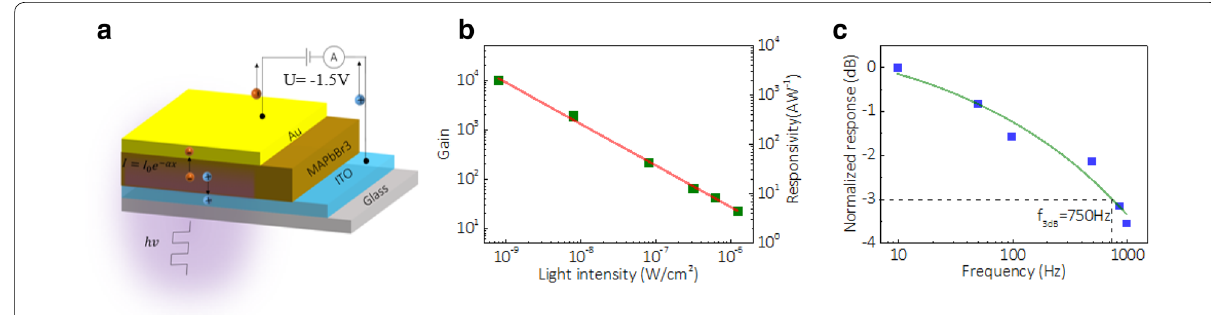
Fig. 4 Characterization of MAPbBr 3 SC‑TF photodetector. a Structure of the device. The film is sandwiched in the ITO substrate and top Au electrode, forming a metal–semiconductor‑metal structure. b Gain and responsivity of the device at different incident power density. The largest gain is ~ 10 4 which benefits from the high crystallinity and thin thickness of the active layer. c 3 dB bandwidth of the device is measured as 750